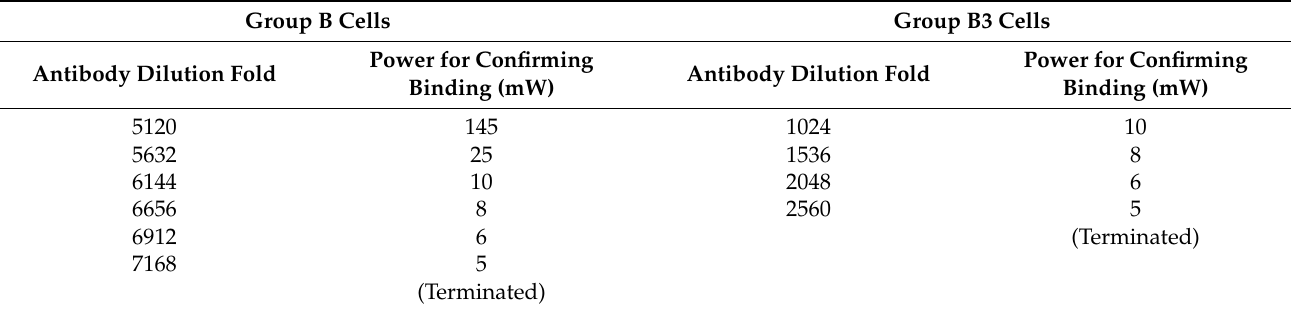
Table 3. Cell-tearing assays with a serial antibody dilution using gradually decreased powers. Group B Cells